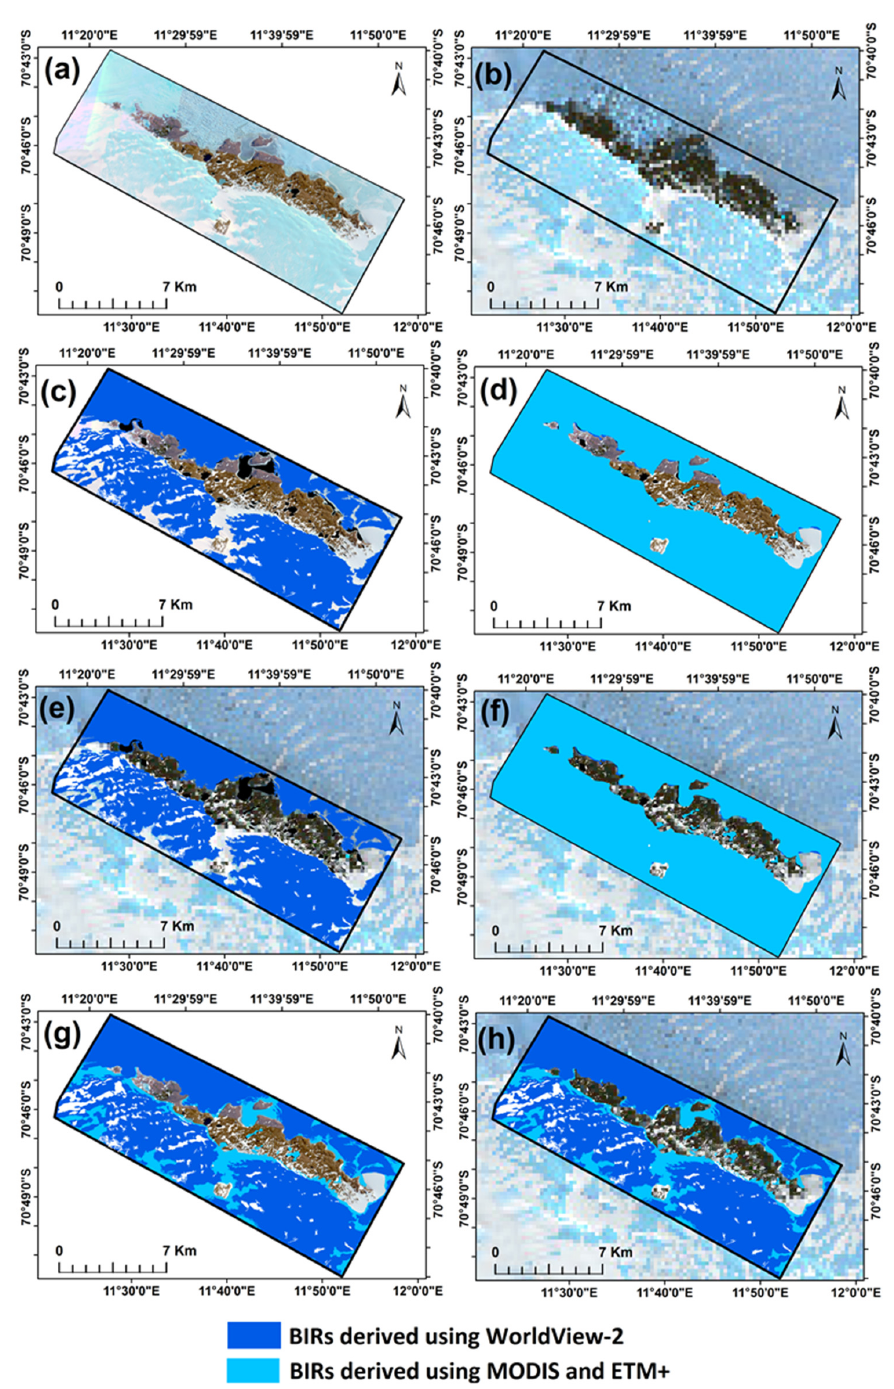
Figure 10. Visual image analysis of extracted blue ice regions from the entire study area using WV-2: ( a ) WV-2 imagery showing the spatial extent of the study area; ( b ) extent of the present study on LIMA mosaic; ( c ) BIRs derived using WV-2 appended on PAN-sharpened WV-2 satellite imagery; ( d ) BIRs derived from MODIS/ETM+ appended on WV-2 satellite imagery; ( e ) BIRs derived from WV-2 appended on LIMA mosaic, ( f ) BIRs derived from MODIS/ETM+ appended on LIMA mosaic, ( g ) BIRs extracted using WV-2 appended on BIRs derived from MODIS/ETM+ to infer the spatial distribution of errors in existing MODIS/ETM+ BIR dataset, as depicted on background WV-2 imagery, ( h ) BIRs extracted using WV-2 appended on BIRs derived from MODIS/ETM+ to infer the spatial distribution of errors in existing MODIS/ETM+ BIR dataset, as depicted on background LIMA imagery. White patches distributed within the study area extent represent